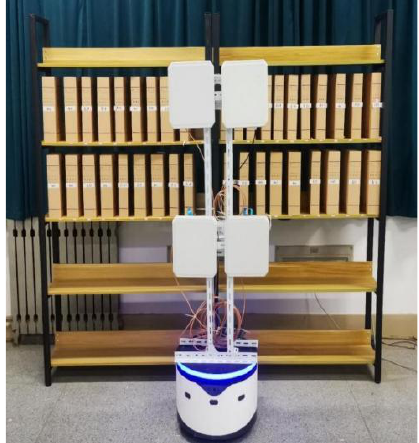
Figure 2. The physical picture of RFID robot.